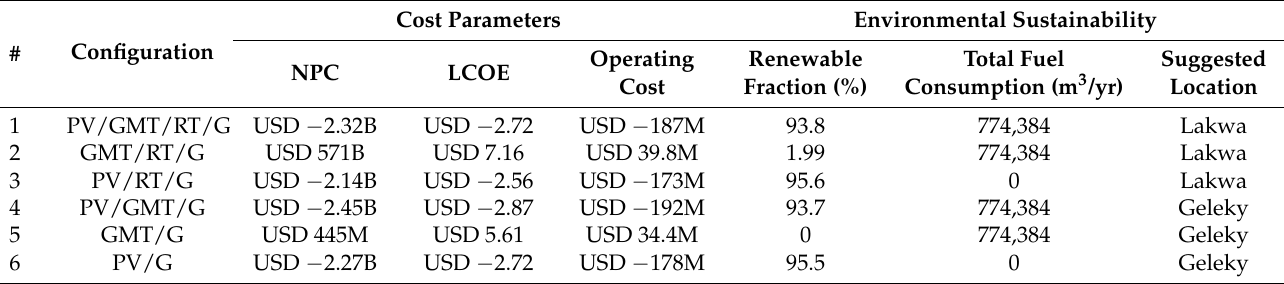
Table 3. Comparison of the selected HES based on cost and environmental